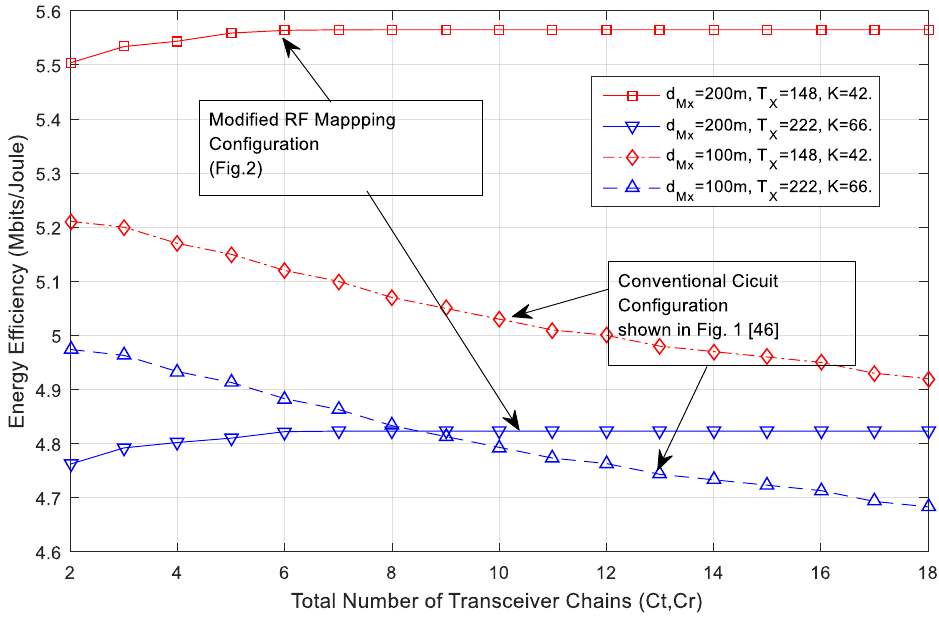
Figure 8. Effects of the transceiver chains on the optimal energy efficiency of the system. Figure 8. E ff ects of the transceiver chains on the optimal energy e ffi ciency of the